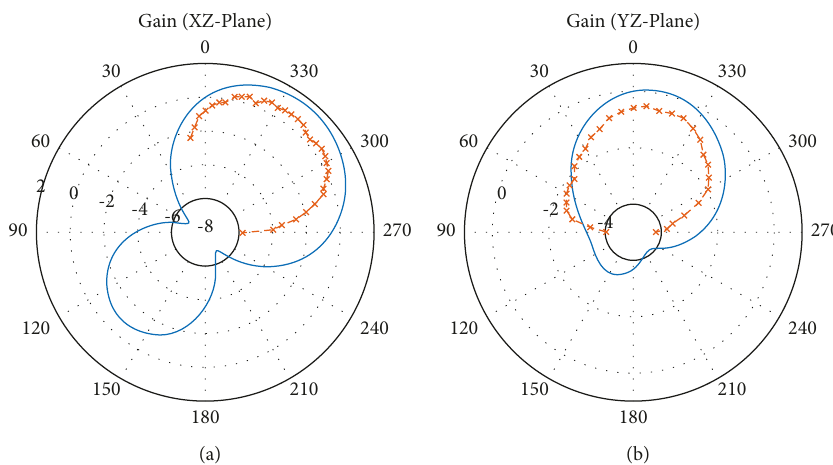
11 | of the on-chip